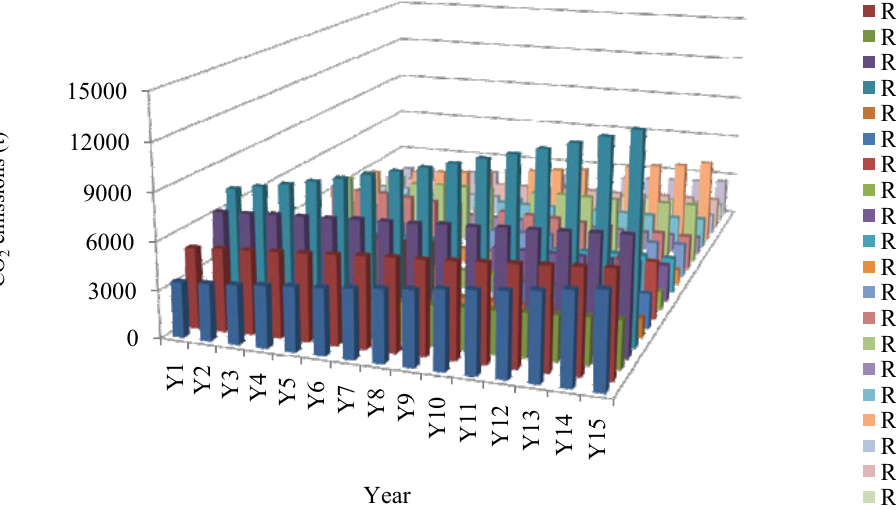
Fig. 2. CO emissions from SWCTT in different district of Tehran from 2 Fig. 2: CO emissions from SWCTT in different district of Tehran from 2018‐2032 2